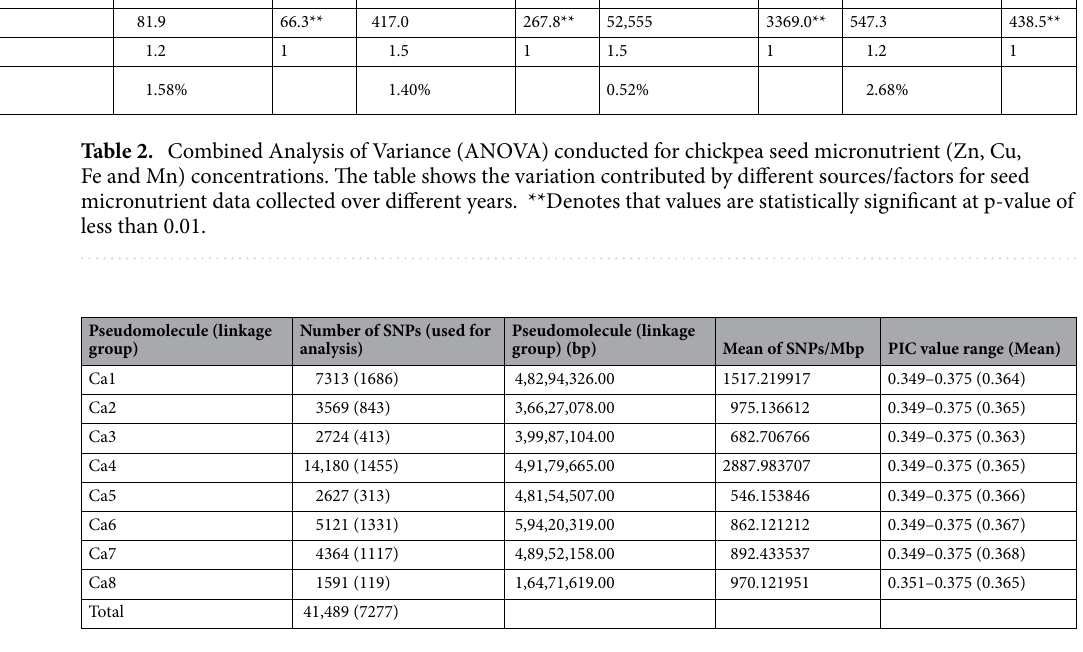
Table 3. Distribution of SNPs on eight different pseudomolecules/chromosomes in chickpea and their polymorphism information content (PIC). The table also shows the number of SNPs available on each chromosomes/linkage group and the number of SNPs used for conducting marker-trait associations during the present study.